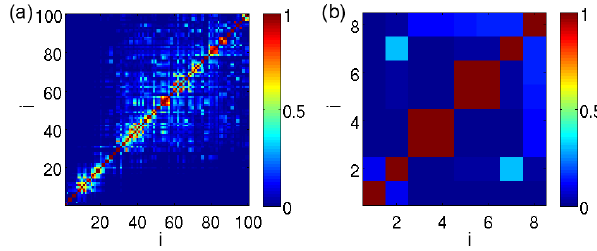
Fig. 6. Logarithmic singular value spectra expressed on percentage (a) for L SSA = 100 and (b) for the first 8 modes.